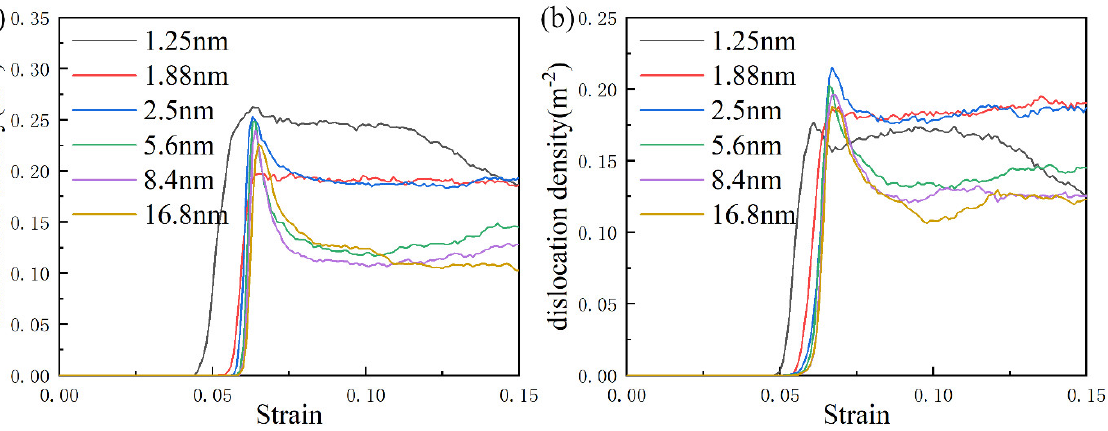
Figure 8. The dislocation density evolution curves during uniaxial compression: ( a ) 50 K, ( b ) 300 K. To reveal the details of the phase transition of Cu/Ta MNCs during compression below and above h C , Figure 9a,b exhibit the phase transition evolution curves for h = 1.25 nm and h = 5.6 nm samples at 300 K, respectively. For the h = 1.25 nm sample, the face-centered cubic structure transforms to the hcp phase at ε = 0.05, while the face-centered cubic and body-centered cubic structures transform to the amorphous phase. For the h = 5.6 nm sample, the same phase transition is observed at ε = 0.06. However, during the strain of 0.075–0.15, more fcc and bcc phases transform to amorphous phases for h = 1.25 nm, as a result of amorphous shear bands, while the proportion of various atomic structures for h = 5.6 nm remains approximately constant.